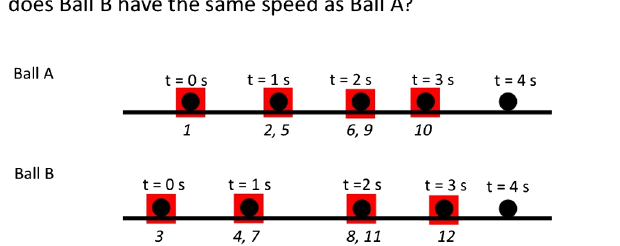
FIG. 10 (color online). Ball problem overlaid with visual cues.